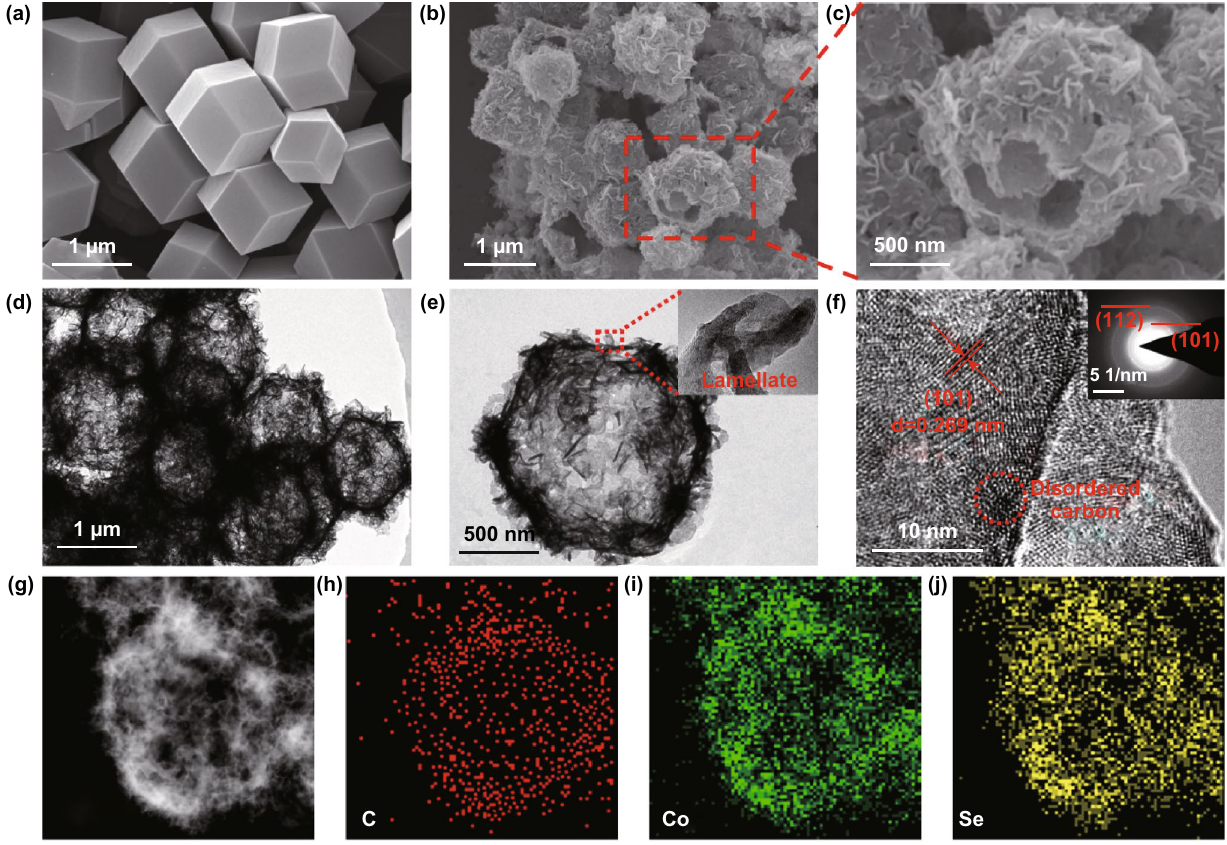
Fig. 2 a SEM images of Co‑based precursor. b, c SEM images and d, e TEM images of Co 0.85 Se‑QDs/C‑20. f High‑resolution TEM image and SAED pattern of